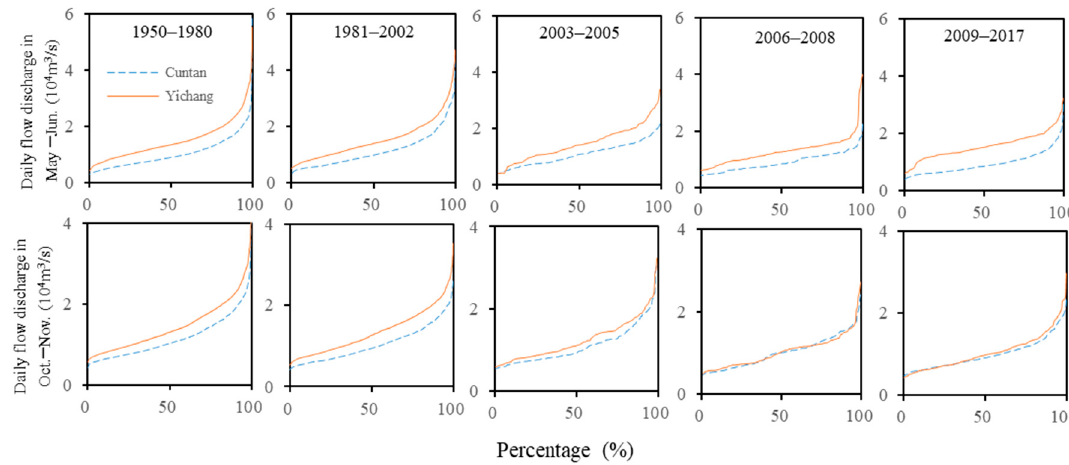
Figure 3. Daily discharge frequency distribution in May–June and October–November for different sub-periods.